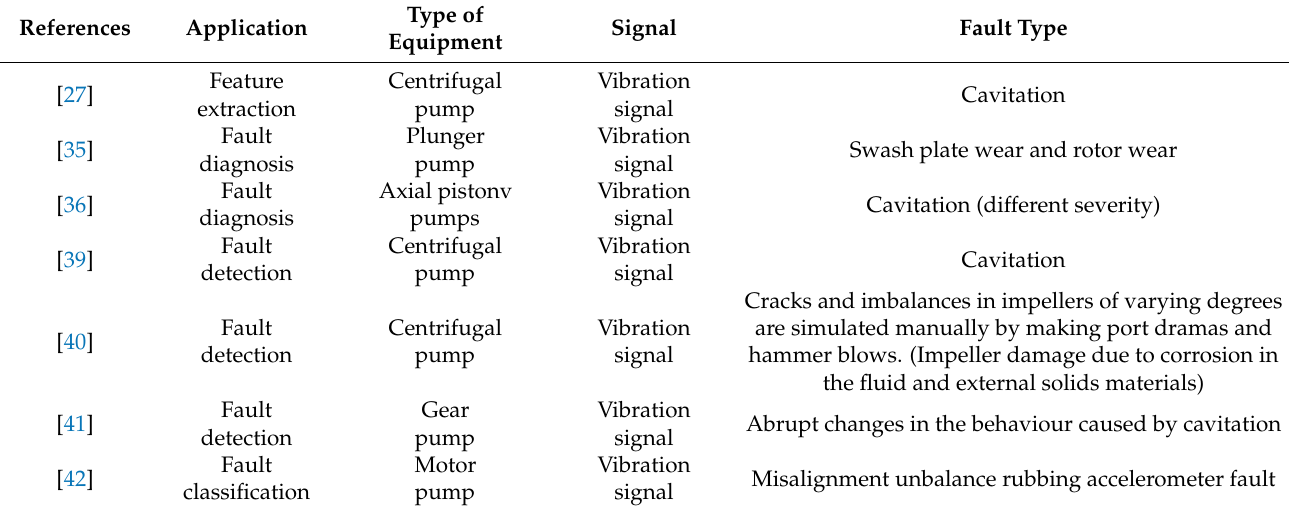
Table 2. Pump condition monitoring using Fourier transform.